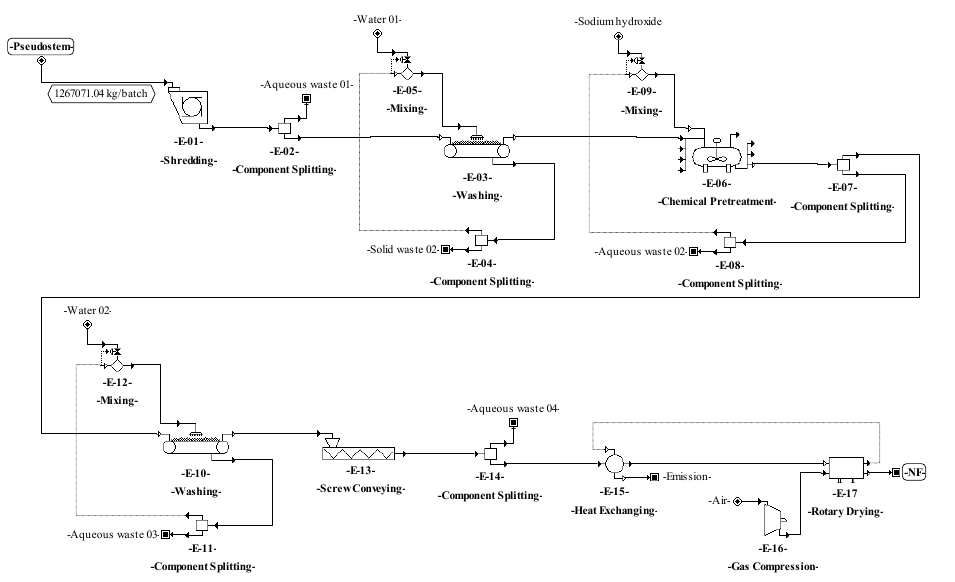
Figure 6. Process flowsheet of natural fiber (NF) production from plantain pseudostems.